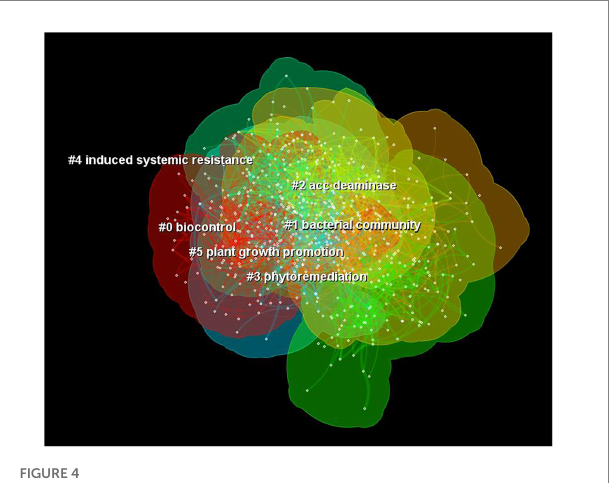
FIGURE 4 Cluster map of co-occurring keywords in rhizosphere microorganism field published from 2012 to